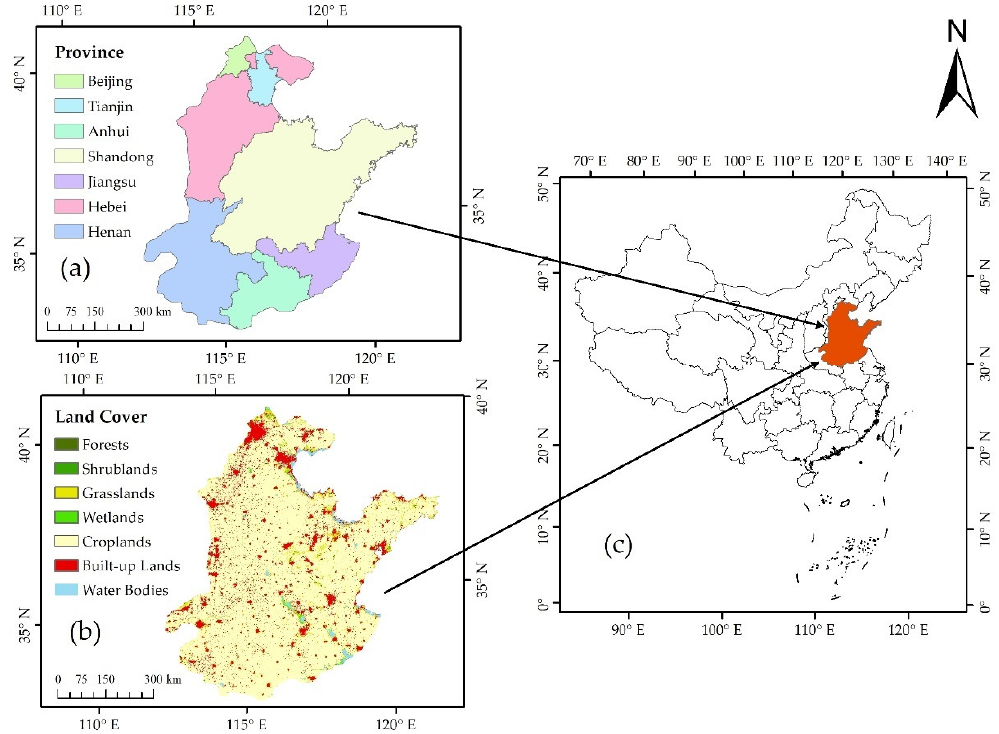
Figure 1. Provinces ( a ) and land cover types ( b ) in the Huang–Huai–Hai Plain (HHHP) and administrative divisions of China ( c ).